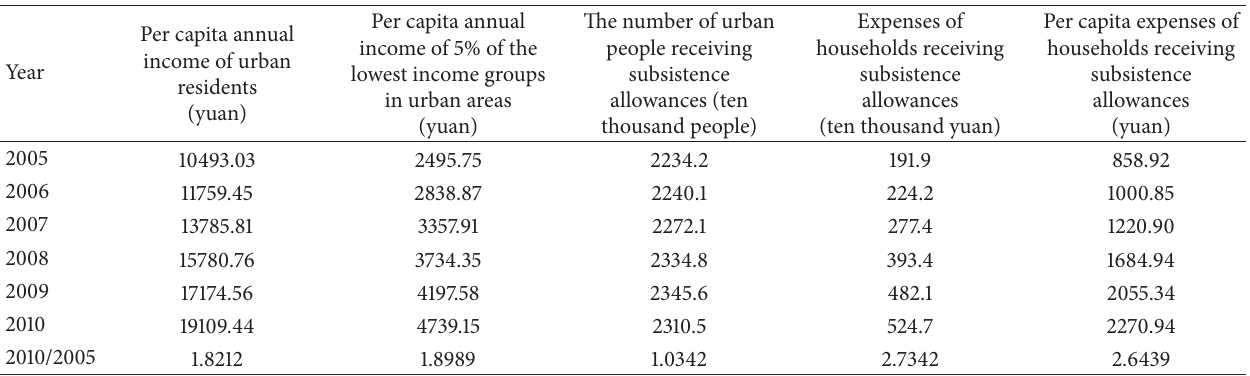
Table 8: Income and subsistence allowance of poor groups in urban areas from 2005 to 2010.